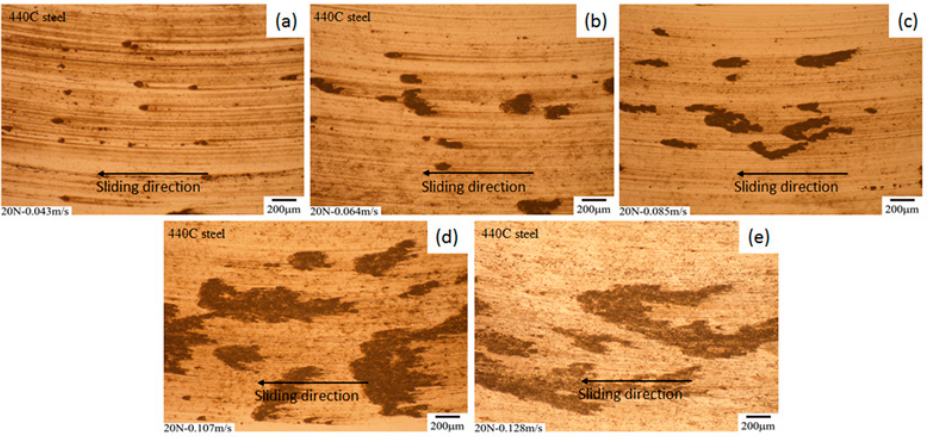
Figure 5. Disk (440C steel) surface images of a wear track under a 20 N load at sliding velocities of ( a ) 0.043 m / s, ( b ) 0.064 m / s, ( c ) 0.085 m / s, ( d ) 0.107 m / s, and ( e ) 0.128 m /